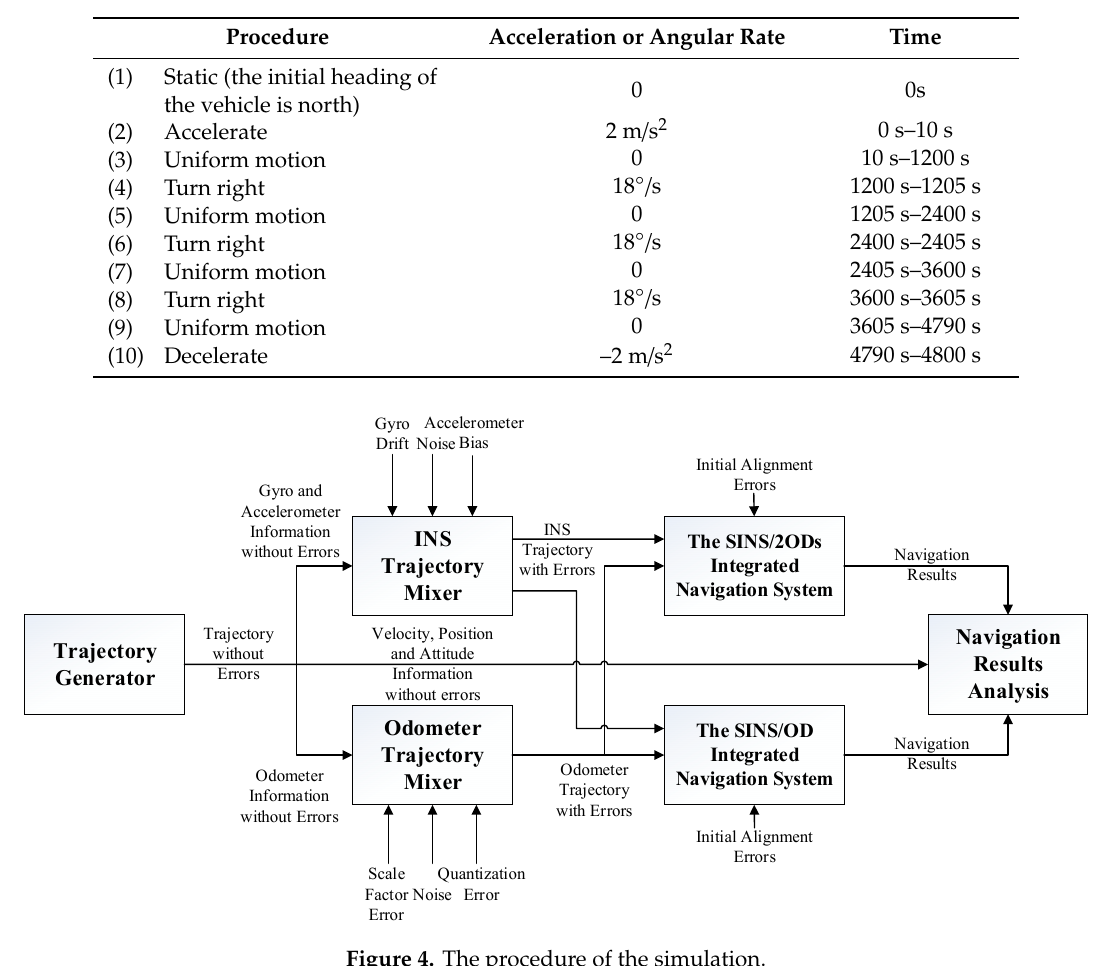
Table 3. The trajectory of the land vehicle.